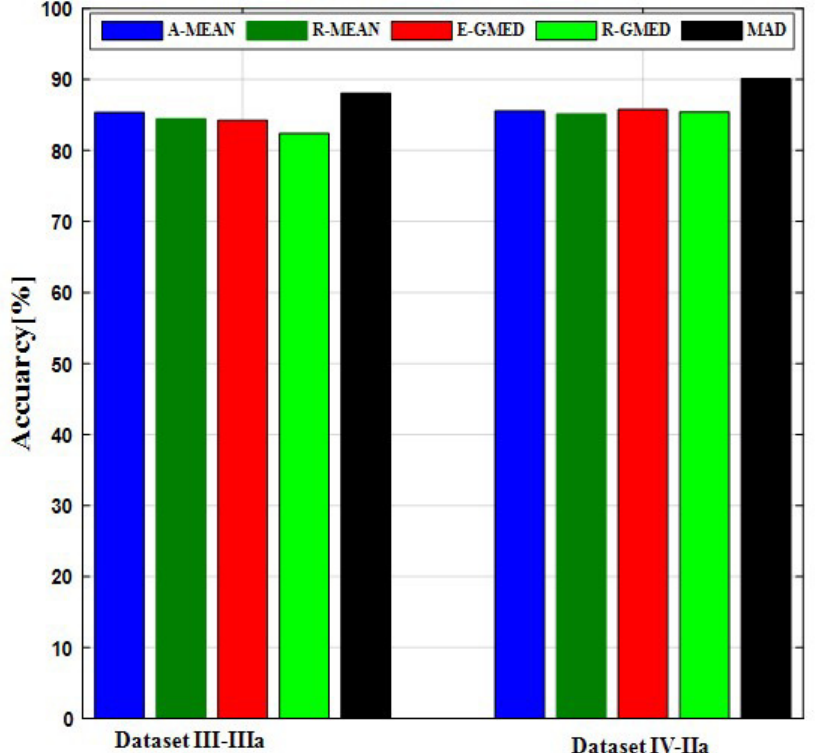
Figure 3. The recognition accuracy of our proposed method along with those of other methods using all